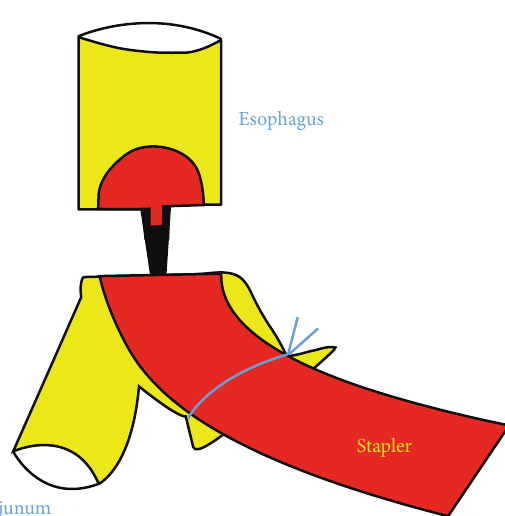
Figure 6: Illustration of the Roux-en-Y esophagojejunostomy.